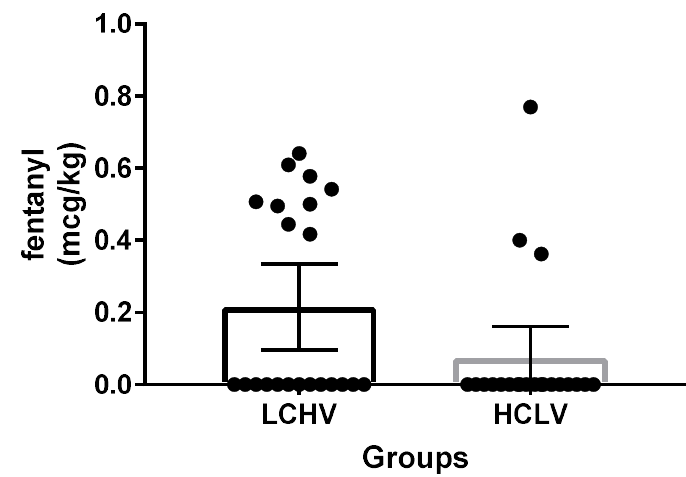
Figure 3. Fentanyl usage at post-anesthetic care unit. LCHV, Low-concentration high-volume; HCLV, high-concentration low-volume.